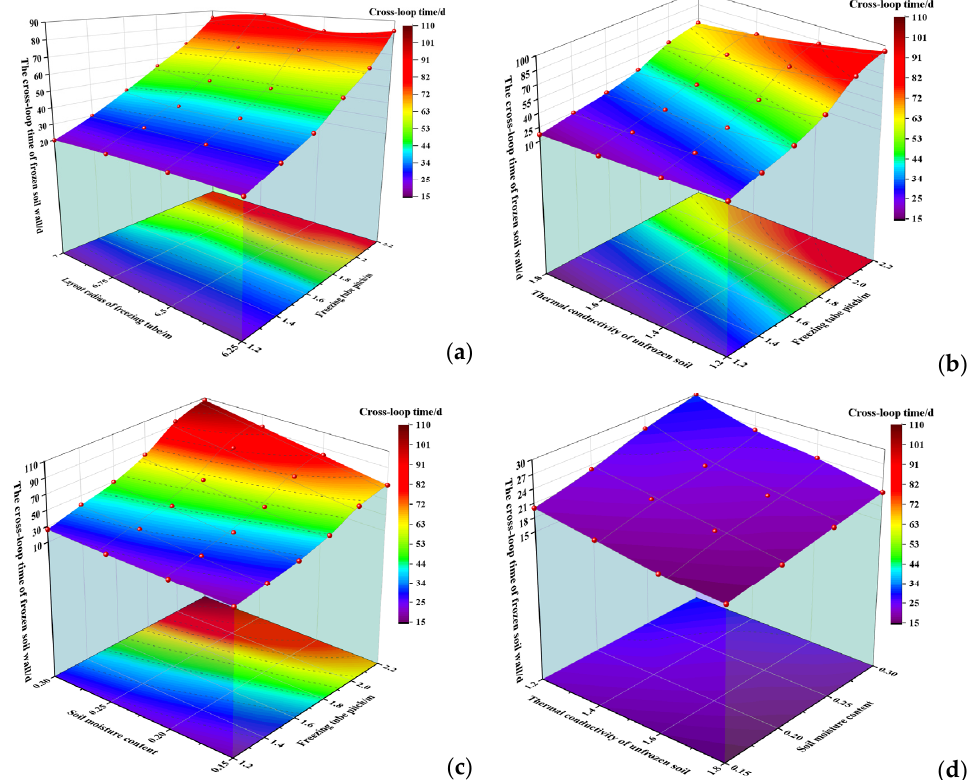
Figure 24. The contours of cross ‐ loop time with different parameters.